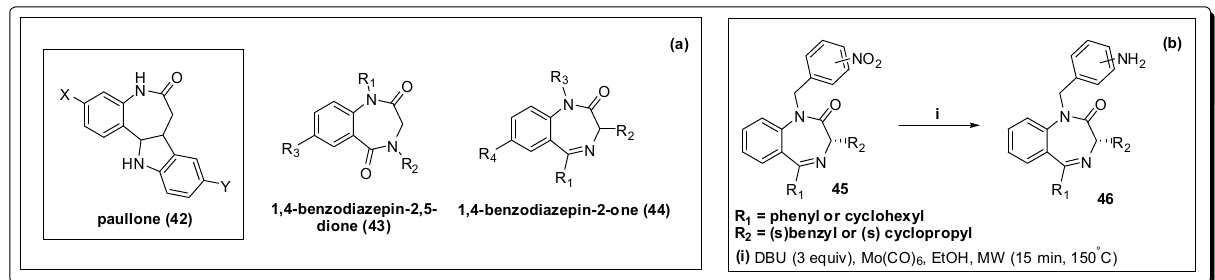
Figure 14. ( a ) Structures of paullone and benzodiazepines; ( b ) Reduction methodology used to obtain the corresponding amino